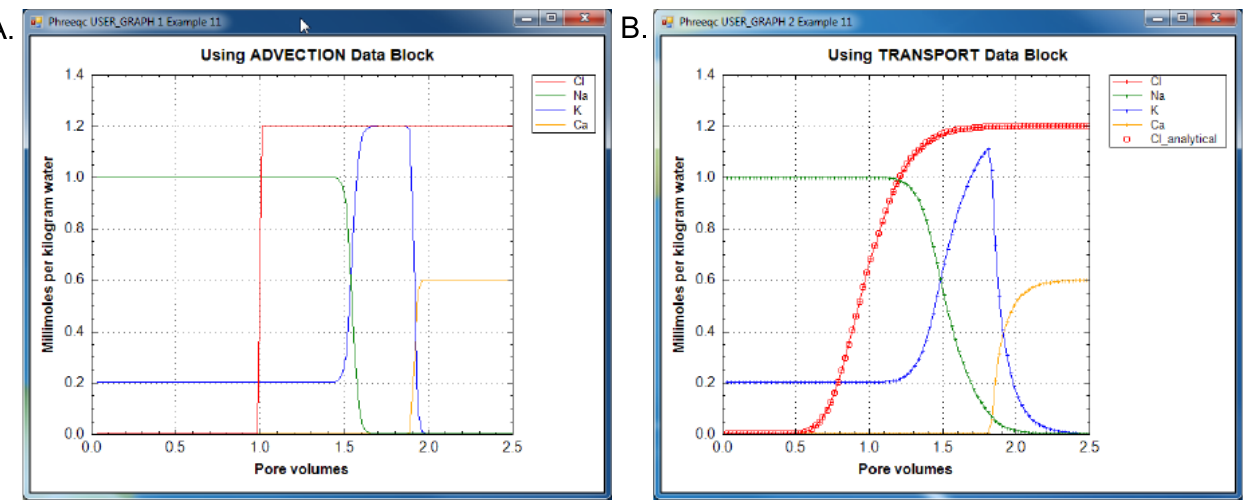
Figure 12. Results of (A) advective and (B) advective-dispersive transport simulations of the replacement of sodium and potassium on a cation exchanger by infilling calcium chloride solution. Lines display concentrations at the outlet of the column as calculated with PHREEQC with advection only ( ADVECTION keyword) and with advection and dispersion ( TRANSPORT